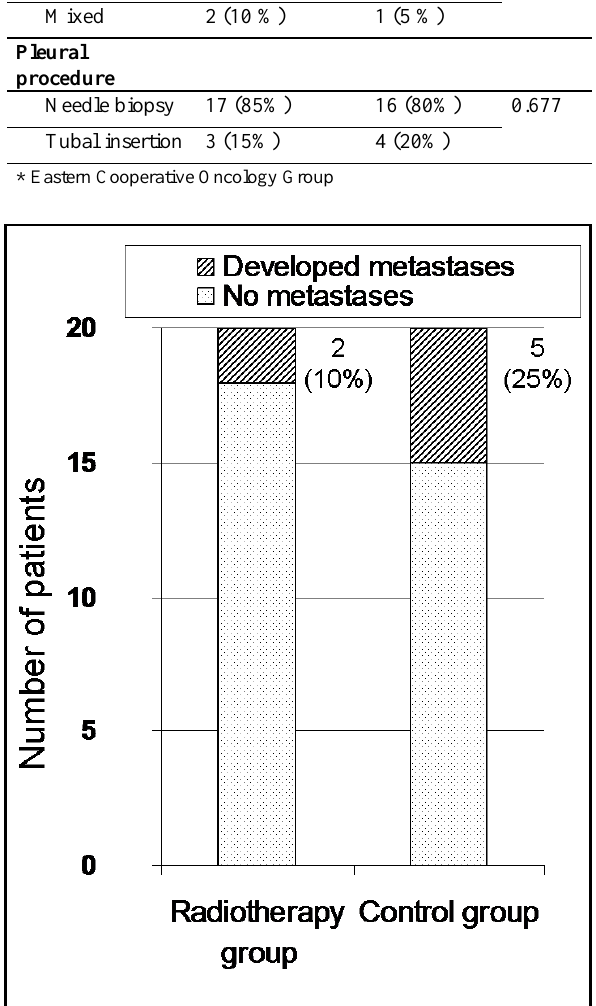
Figure 2: Proportion of patients who developed procedure tract metastasis in both